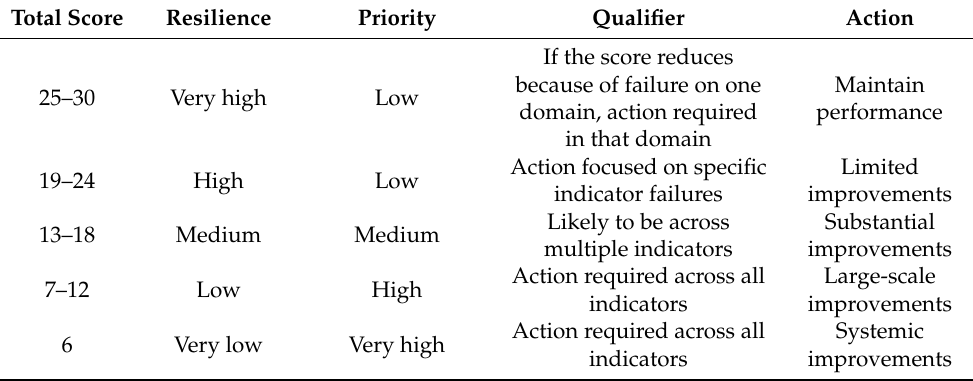
Table 3. Prioritization of water supplies by resilience scores [23] (licensed under CC BY